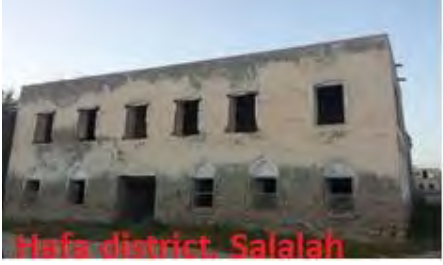
Figure 3. Fac¸ade’s photograph building location